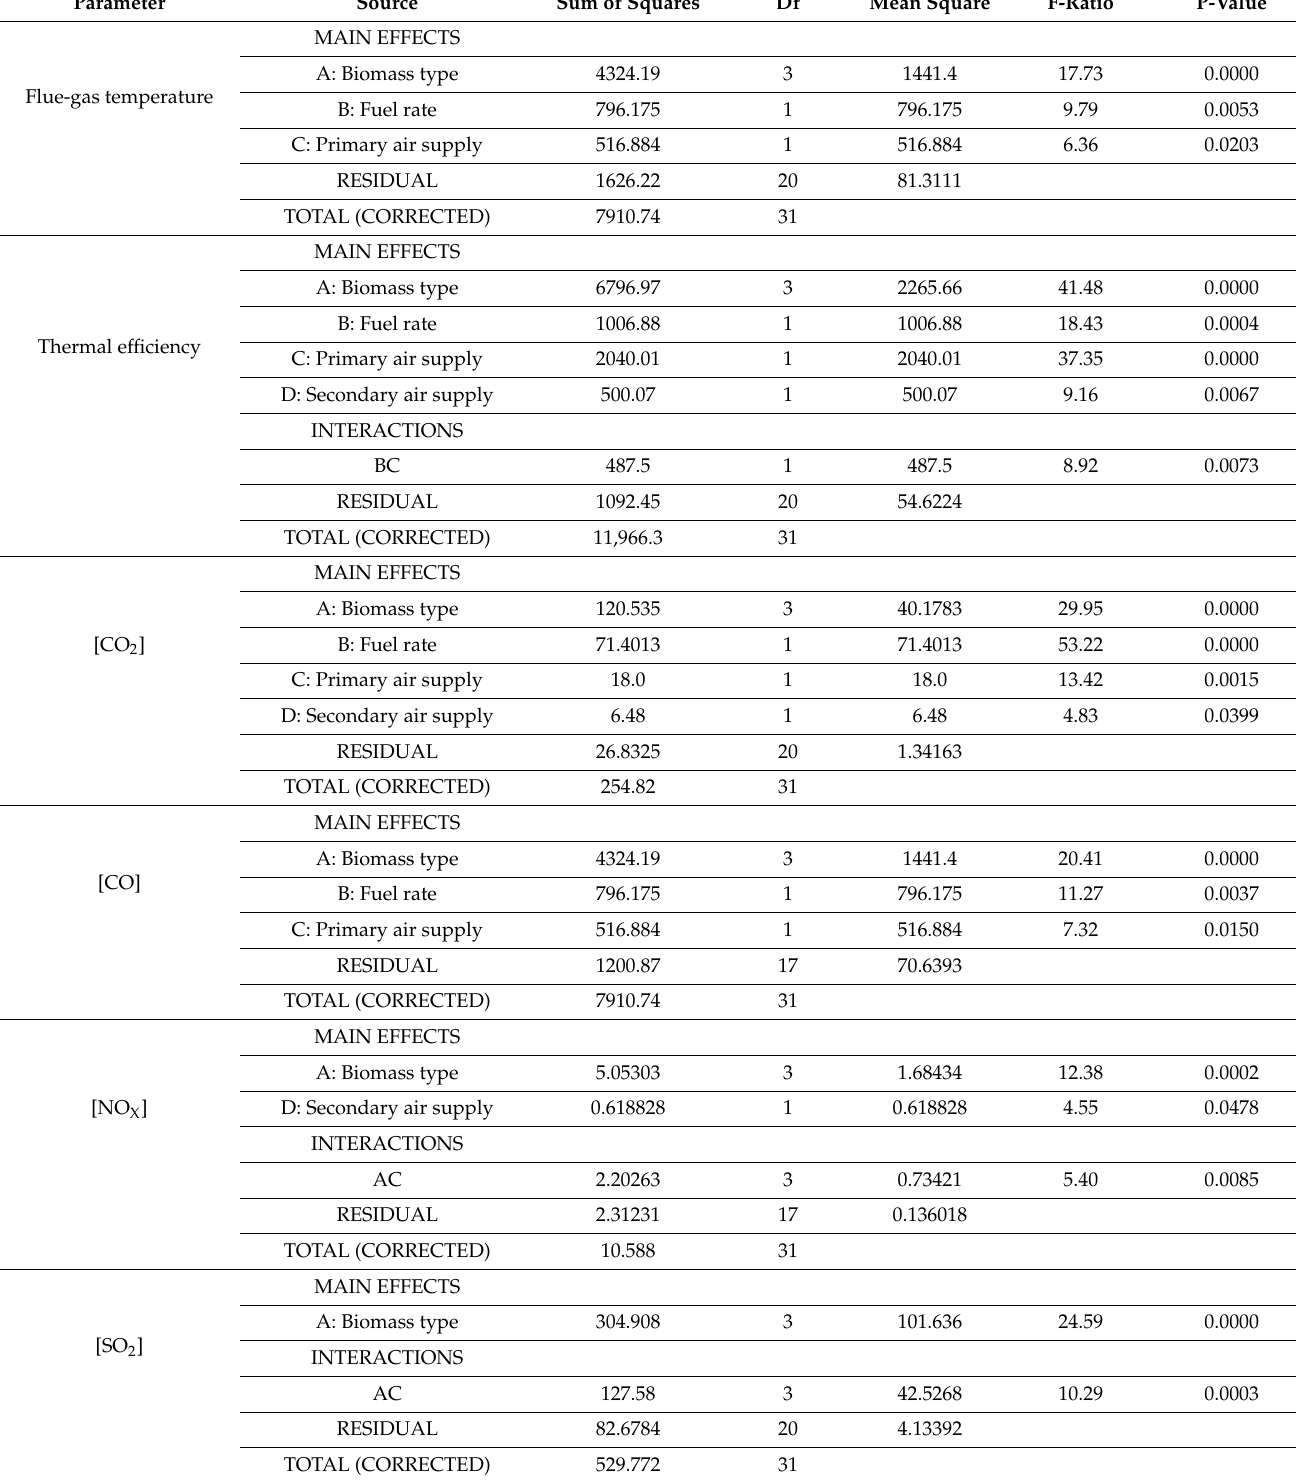
Table A1. Analysis of Variance for the variables studied (Flue-gas temperature, thermal efficiency, [CO], [NO X ], and [SO 2 ])- Type III Sums of